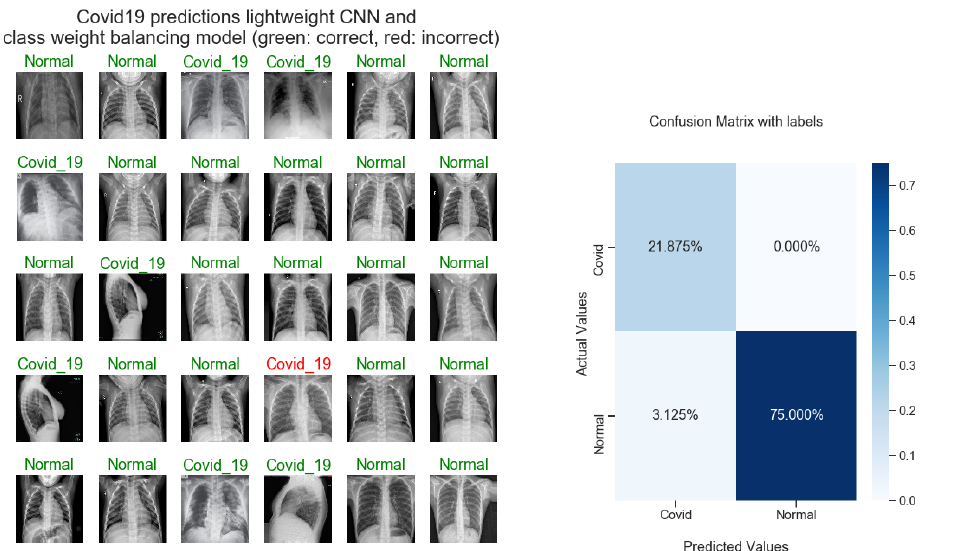
Figure 10. The average case of the proposed model with the Confusion Matrix.